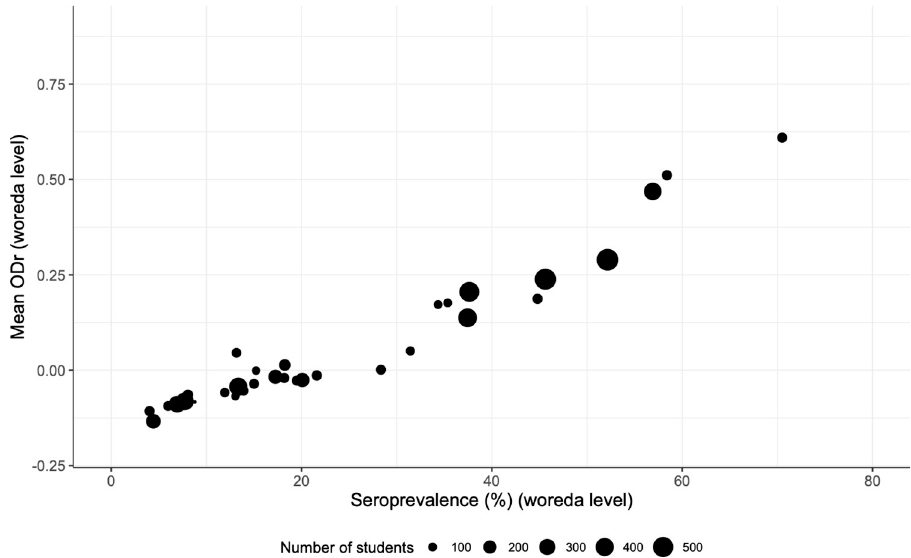
Fig 2. Correlation between seroprevalence and mean optical density ratio on woreda level. The size of the dots indicates the number of screened students per woreda. ODr: optical density ratio (ODr = (OD of sample–OD of negative control)/(OD of positive control–OD of negative